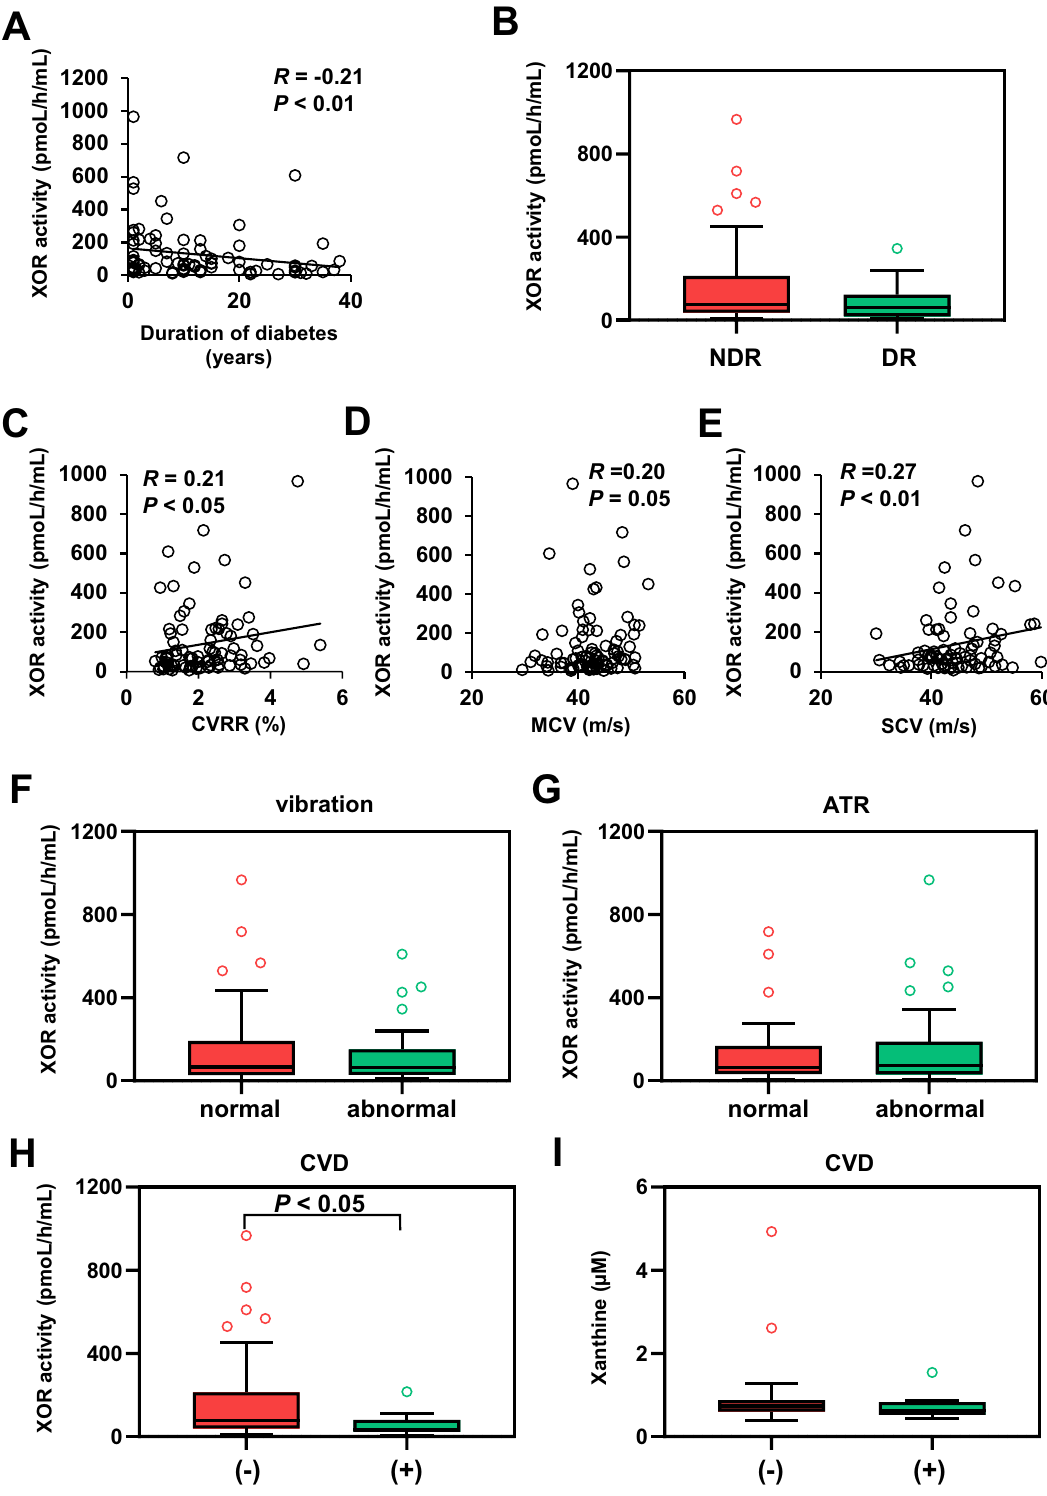
Figure 5. Correlations between plasma XOR activity and diabetic complications. ( A ) Correlation between plasma XOR activity (pmol/h/mL) and the duration of diabetes. ( B ) Plasma XOR activity (pmol/h/mL) in patients with (DR) and without (NDR) diabetic retinopathy. ( C ) Correlation between plasma XOR activity (pmol/h/mL) and coefficient of variation of the R-R interval (CVR-R) (%). ( D ) Correlation between plasma XOR activity (pmol/h/mL) and tibial nerve motor conduction velocity (MCV) (m/s). ( E ) Correlation between plasma XOR activity (pmol/h/mL) and peroneal nerve sensory conduction velocity (SCV) (m/s). ( F ) Plasma XOR activity (pmol/h/mL) in patients with normal and abnormal vibration sense. ( G ) Plasma XOR activity (pmol/h/mL) in patients with normal and blunted Achilles tendon reflex. ( H ) Plasma XOR activity (pmol/h/mL) in patients with or without cardiovascular disease. ( I ) Plasma xanthine concentrations (µM) in patients with and without cardiovascular